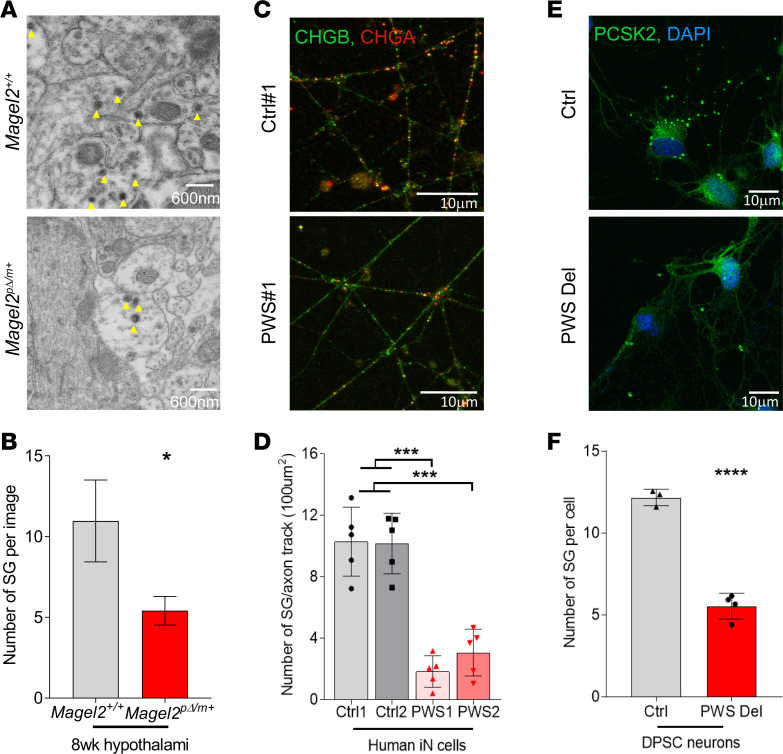
SG biogenesis is impaired Magel2pΔ/m+ mice, human iN with PWS deletion, and DPSC-derived neurons in PWS patients.(A and B) Representative images (A) and quantitation (B) of SG (yellow arrows) by electron microscopy of 8-week-old Magel2+/+ and Magel2pΔ/m+
+ mouse medial eminence region of hypothalamus, n = 2 per genotype; >30 images were analyzed. Data shown as mean ± SD and analyzed by unpaired, 2-tailed t test; *P < 0.05. (C and D) Representative images (C) and quantitation (D) of immunofluorescence staining with CHGB and CHGA in control and PWS iN. Each data point represents 1 induction experiment (n = 5), plotted as mean ± SD and analyzed by 1-way ANOVA. (E and F) Representative images (E) and quantitation (F) of immunofluorescence staining with PCSK2 and DAPI in control and PWS deletion DPSC-derived neurons. Each data point represents 1 individual, plotted as mean ± SD and analyzed by unpaired, 2-tailed t test. *P < 0.05, ***P < 0.001, and ****P < 0.001.